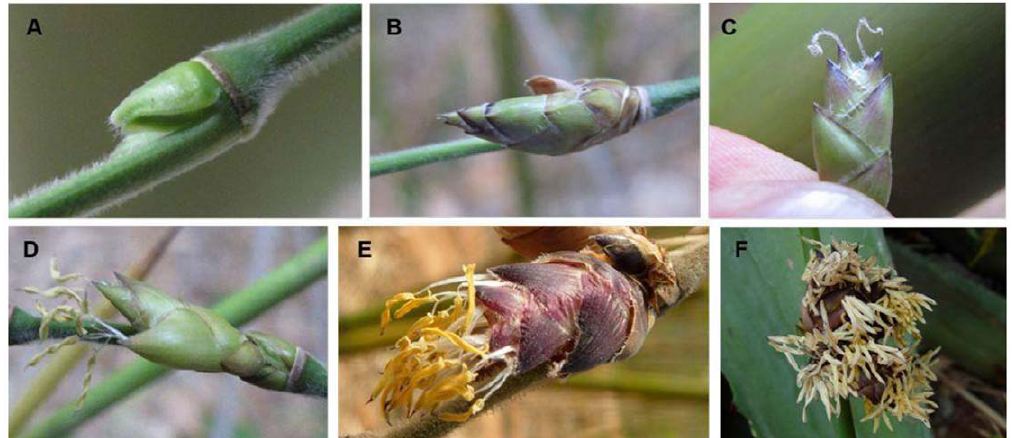
Figure 6. Examples of sampled floral tissues. A. Representatives of flowers collected to produce the sample for phase 1 (flower buds # 5 mm). B–F. Representatives of flowers collected to produce the sample for phase 2 (flower buds $ 5 mm). B. Flowers with pistils and stamens not yet emerging from glumes. C. Flowers from which only pistils have emerged from glumes. D. Flowers with both pistils and stamens emerging from glumes. E. Flowers for which anthers have already dehisced. F. Senescing